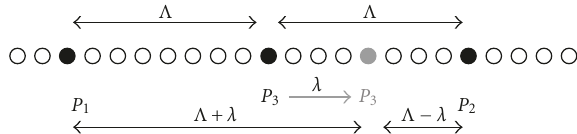
Figure 4: If a pilot moves away from one pilot, it becomes closer to another pilot in its